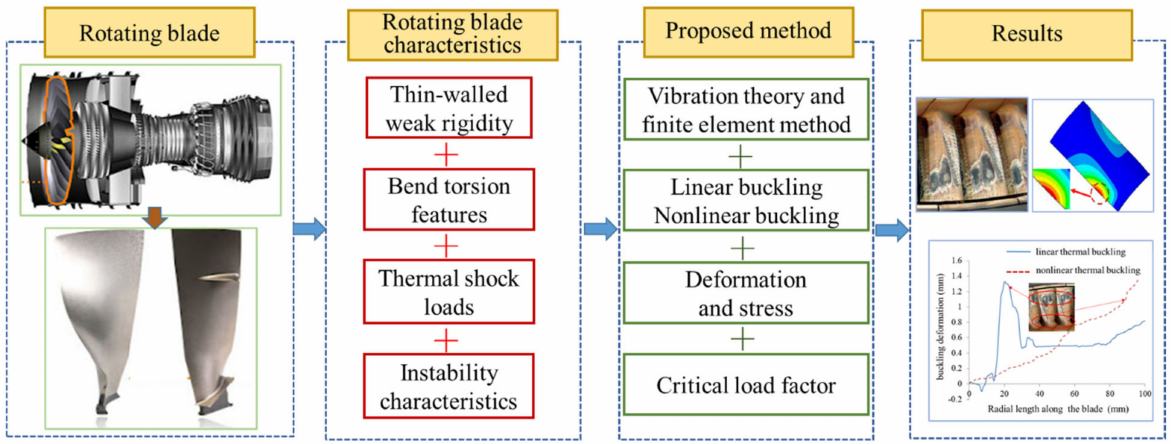
Figure 1. The analytical framework of the